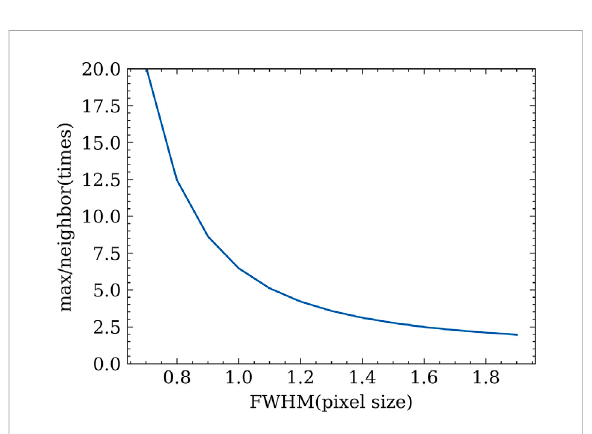
FIGURE 4 The ratio of the max pixel value to the neighbor pixel value changed with the FWHM beam size.